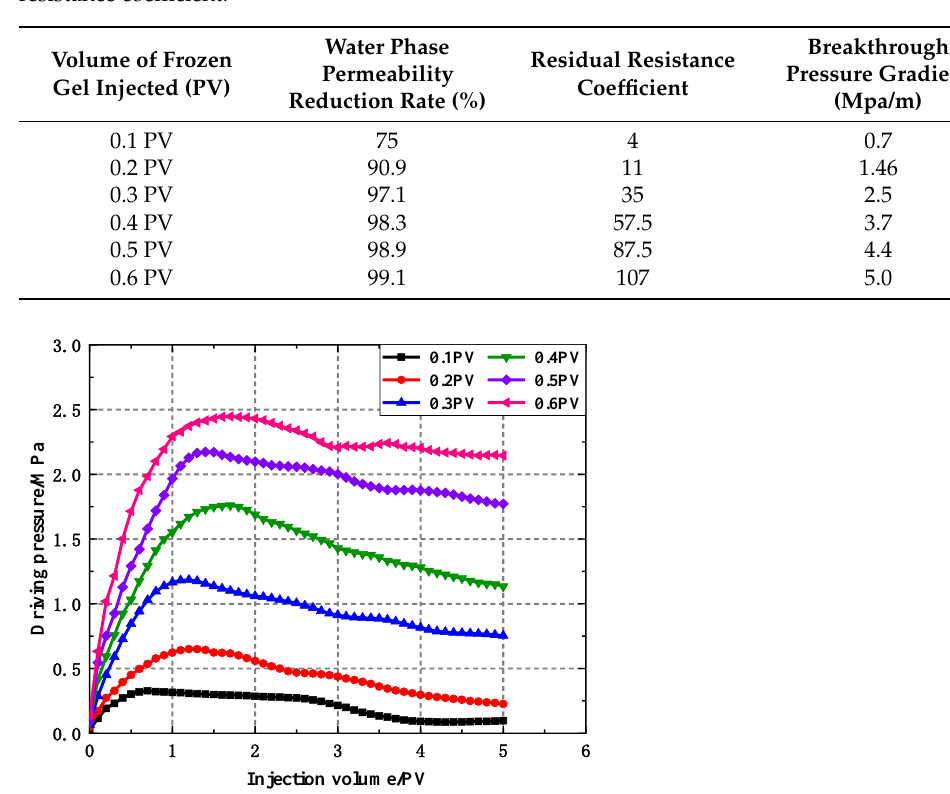
Table 7. Effect of the amount of frozen gel injected on the water plugging rate and the residual resistance coefficient.